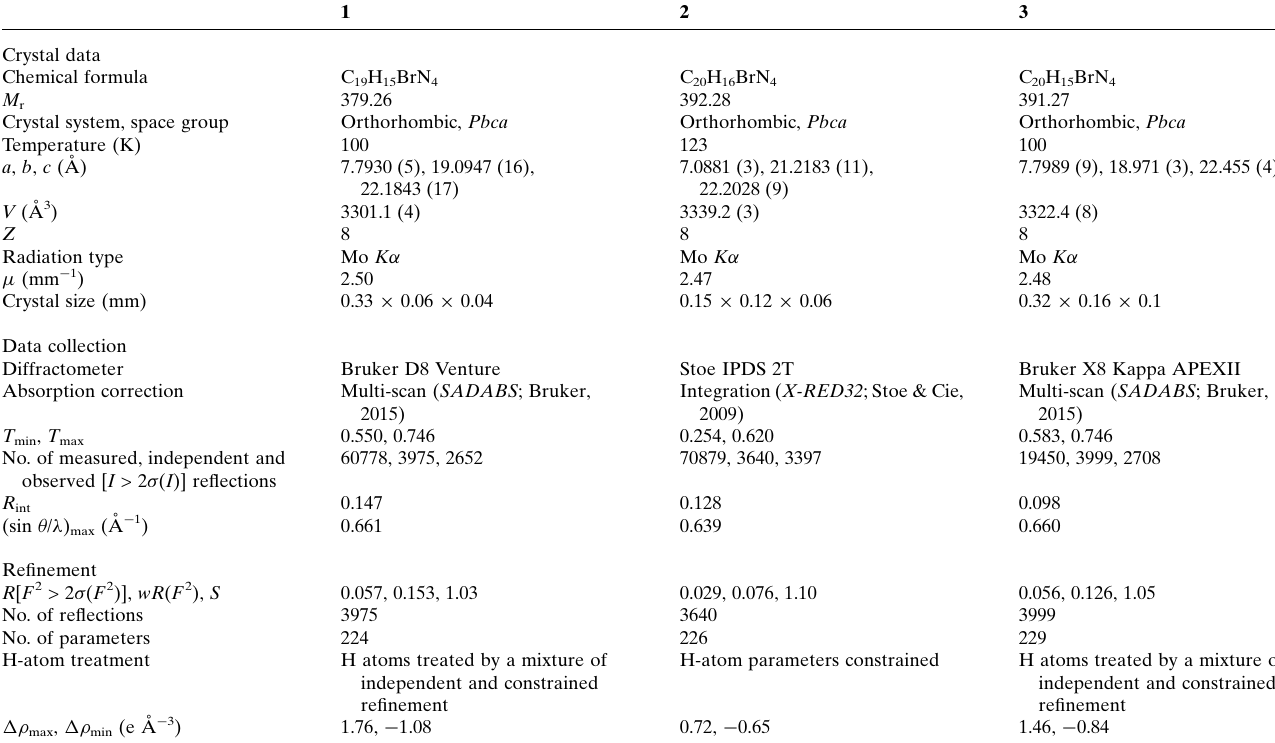
Table 3 Experimental